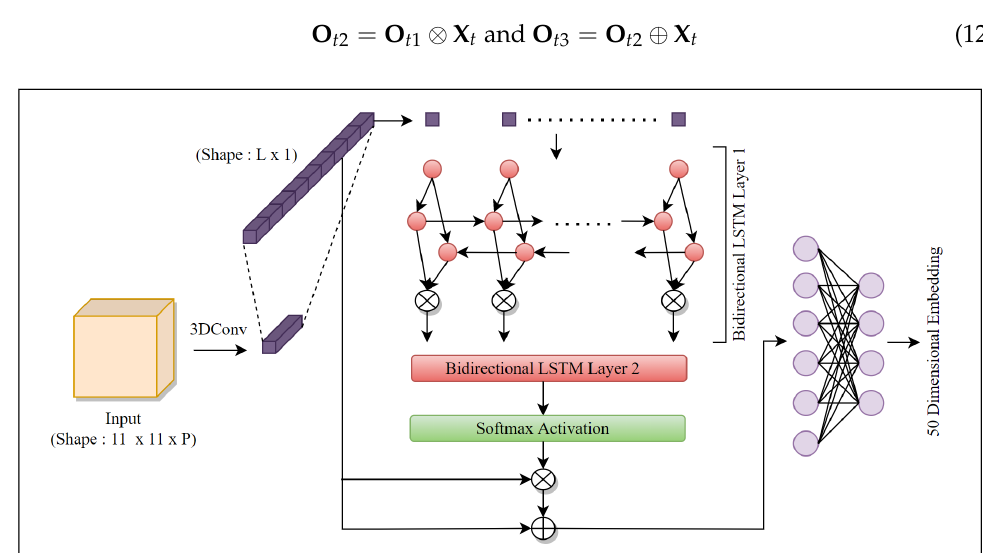
Figure 2. The architecture of the proposed bi-directional LSTM-based spectral attention module from Figure